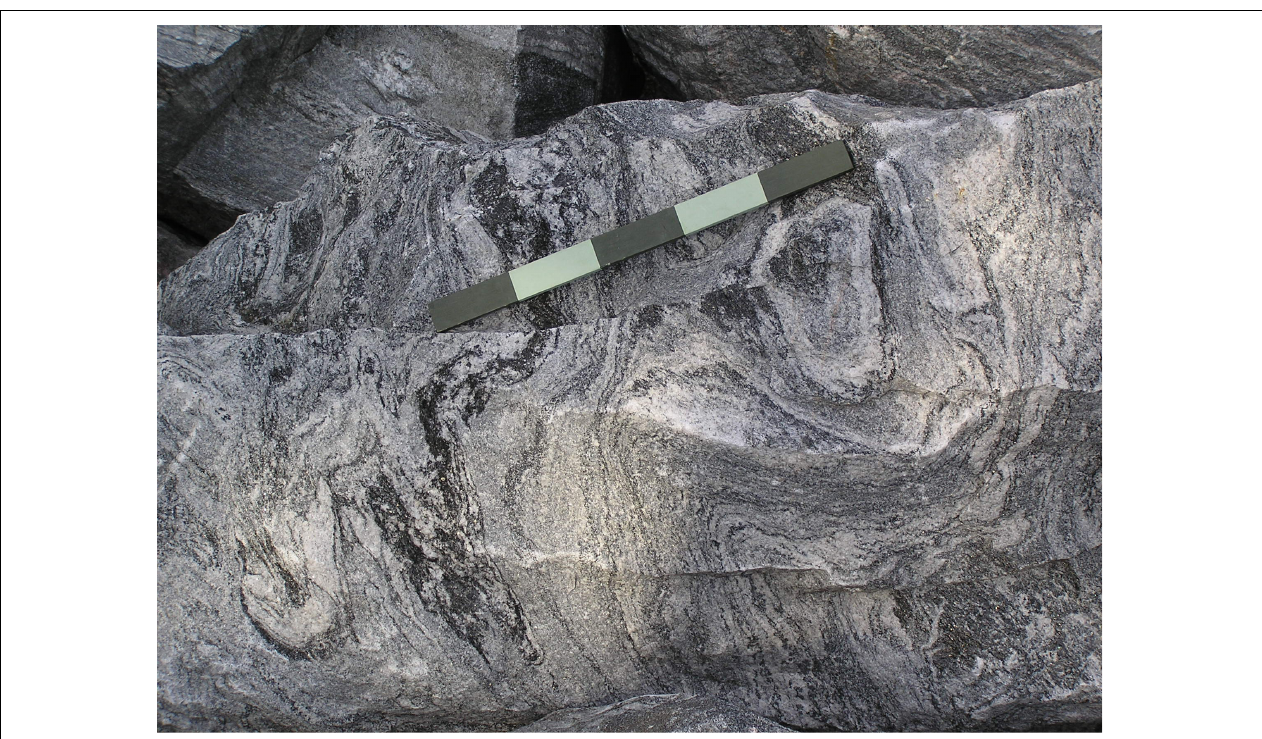
FIGURE 12 | Schlieren diatexite, Näätämö, Lake Inari Complex of the Kola Craton, NE Finland. Same outcrop as in Figure 11 . Length of scale 50 cm. Photo: Pekka